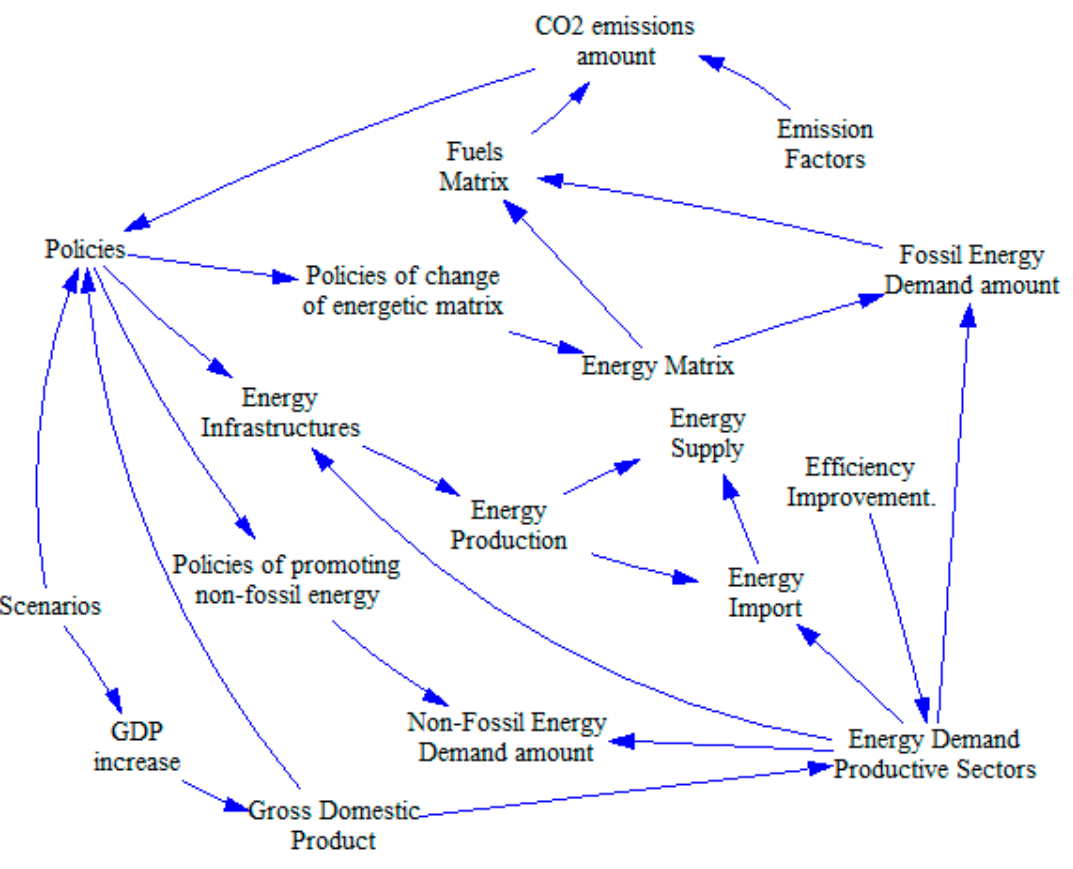
Figure 1. Flow diagram of the energy system and production of carbon emissions in Ecuador (adapted from [18]).